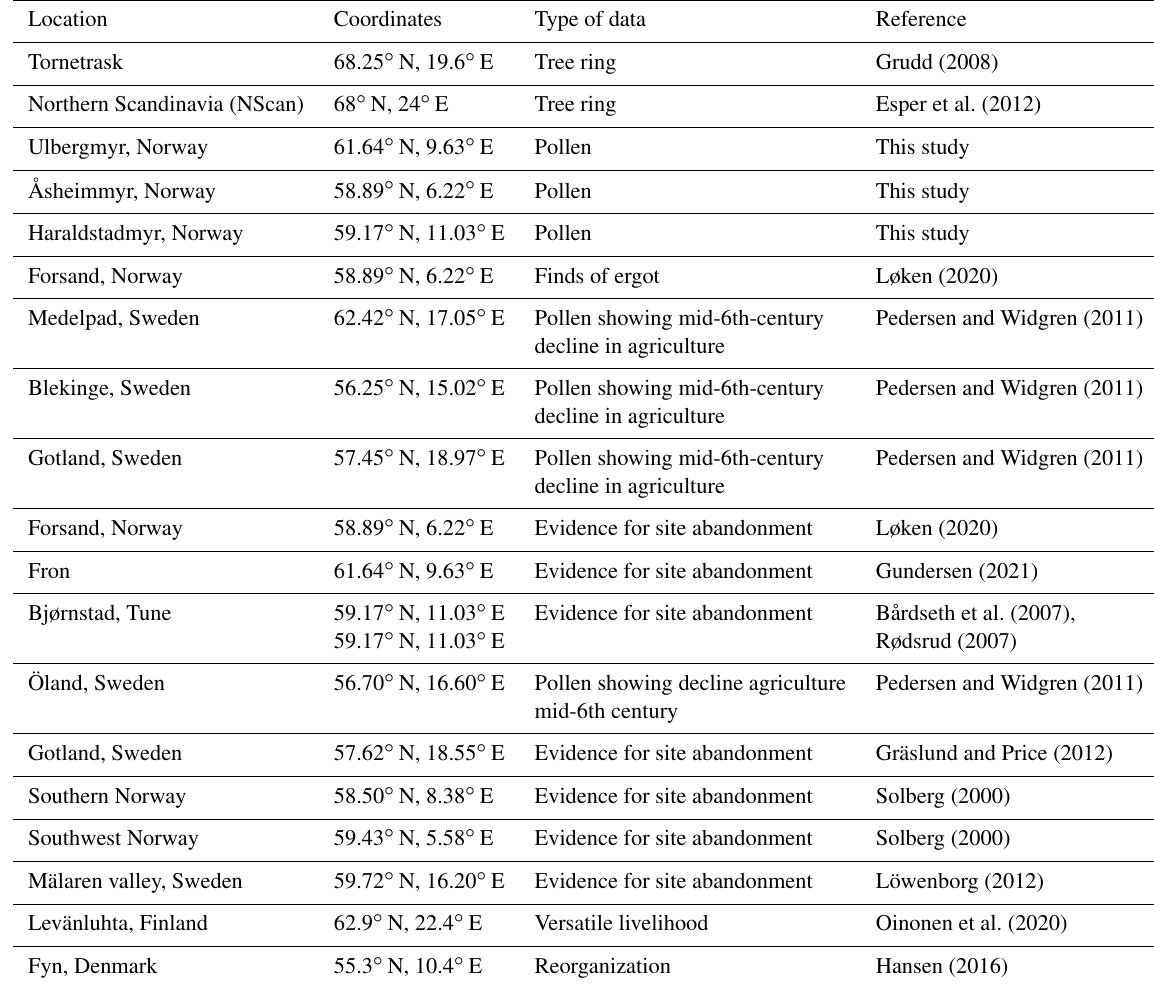
Table A4. Information about the proxies and locations marked in Fig. 9.